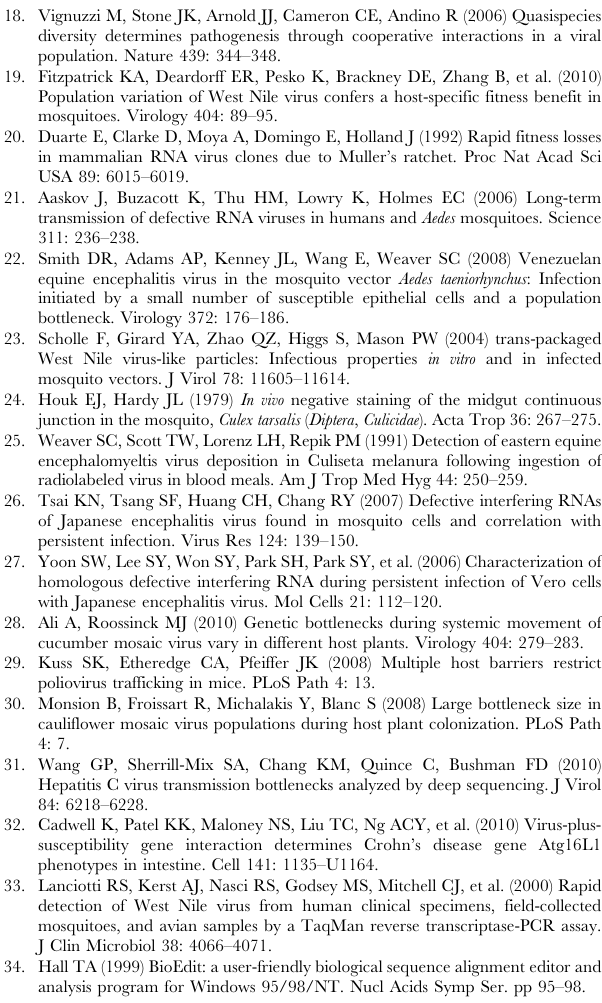
Figure S4 The proportion of wild-type WNV when competed against a marked reference virus does